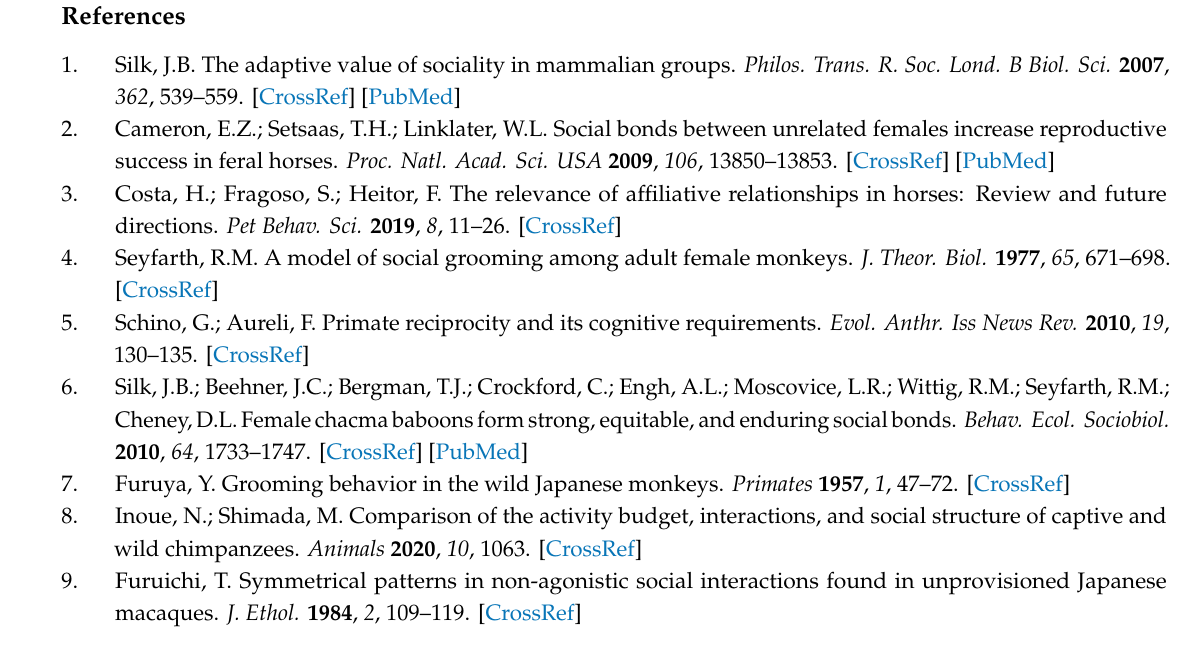
Table S1. Sex, age at time of study period, kinship, and total observation time for “6m” herd members.; Table S2. Frequency of aggressive interaction, s’, eigenvector centrality, and total durations of self-grooming (min) and mutual grooming (min); Table S3. Winner / loser matrix. Left column shows name of winning individual. Top row shows name of losing individual. Numerical value at upper right of diagonal component indicates number of wins. Numerical value at lower left indicates number of losses—indicates no aggressive interaction observed in pair. The number in parentheses represents the number of aggressive interactions that ended in a